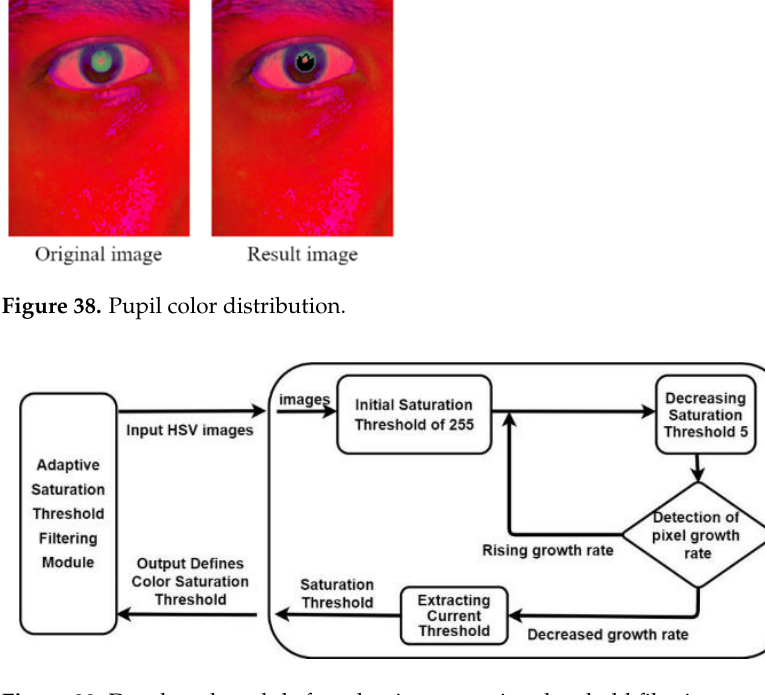
Figure 37. First decline in the pixel growth ratio.